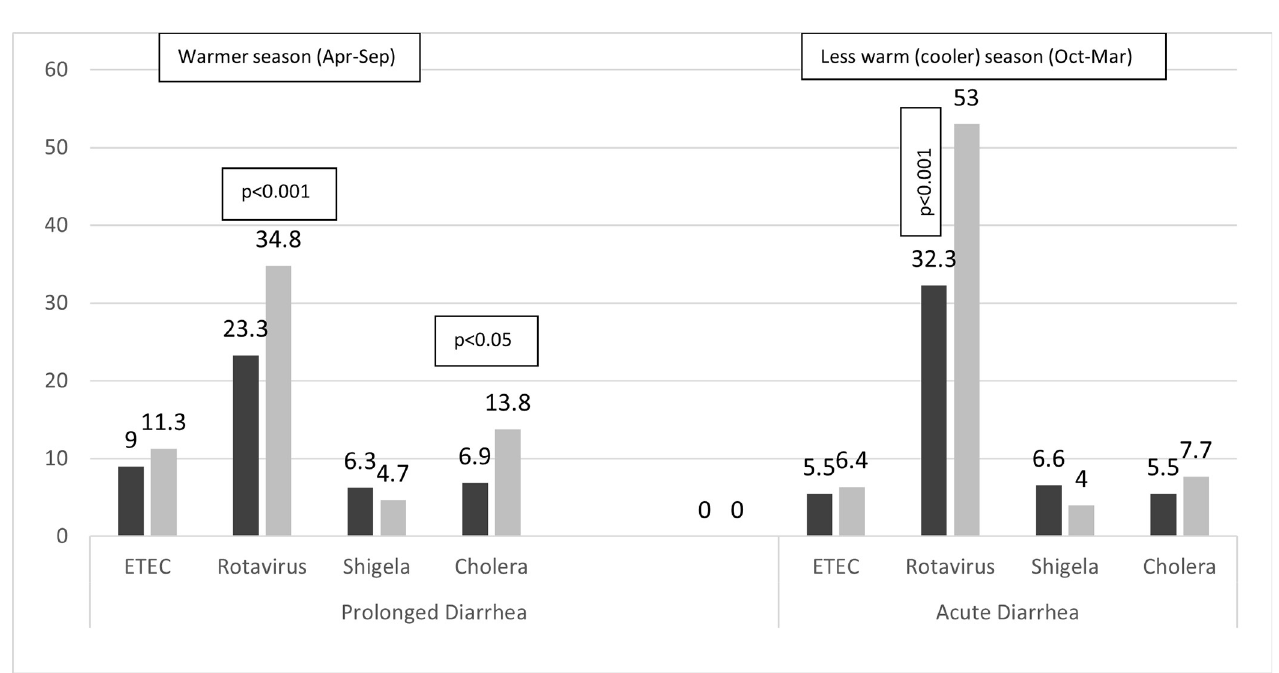
Fig 6. Stool isolates (%) in children with prolonged and acute diarrhea by warmer or less warm/cooler